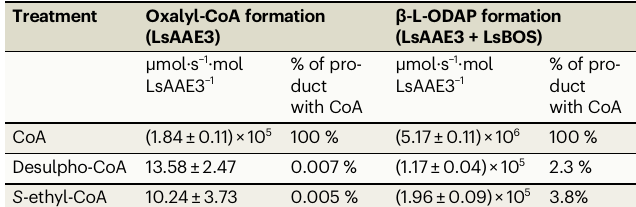
Table 3 | Effect of non-reactive CoA-analogues on LsAAE3 oxalyl-CoA formation and LsAAE3 + LsBOS β